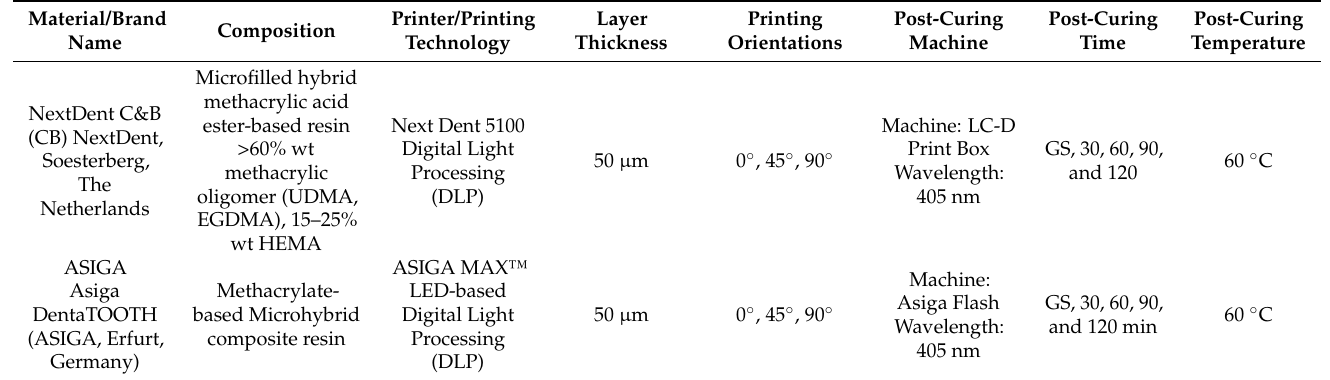
Table 1. Speci fi cations and fabrication methods of materials used in the present study. Table 1. Specifications and fabrication methods of materials used in the present study.